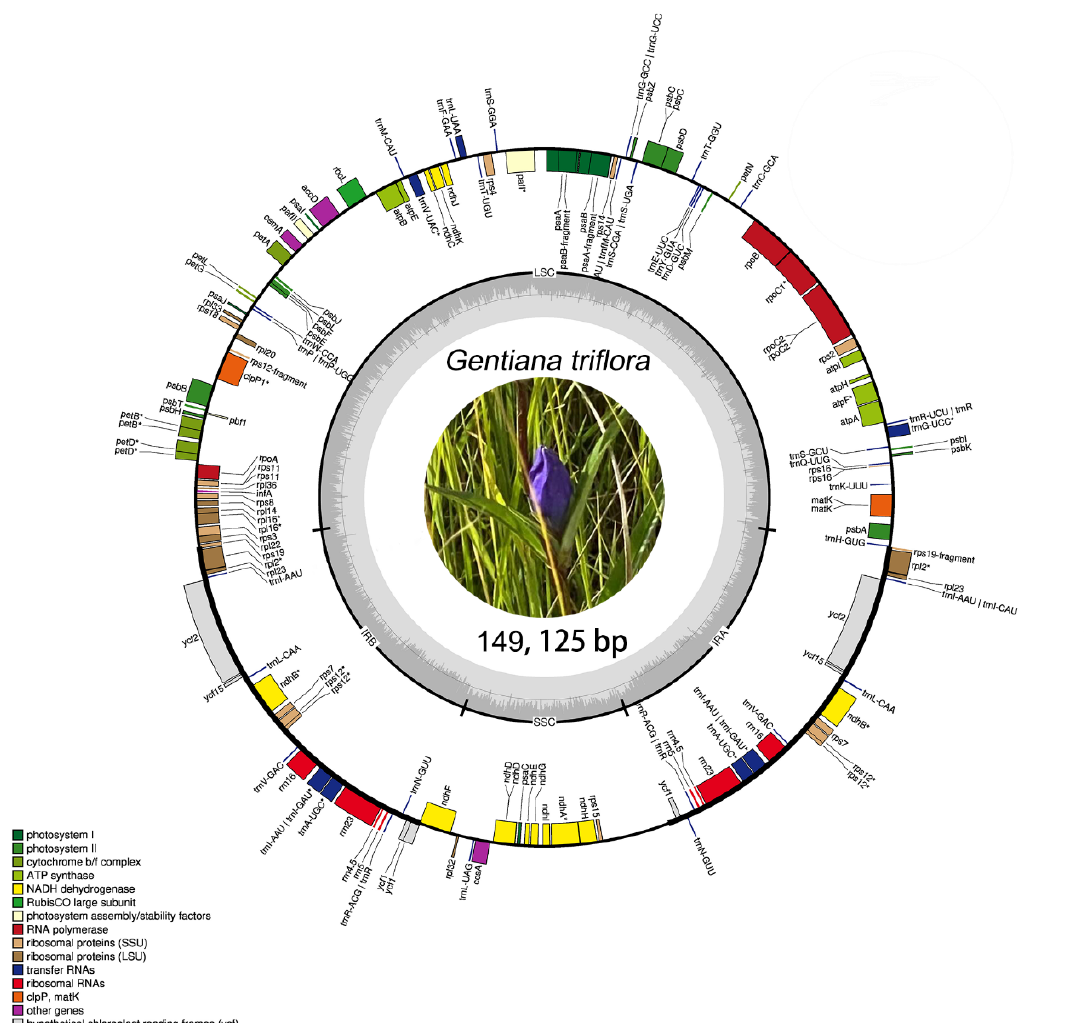
Fig. 1: Gene map of G. triflora chloroplast genome. Thick lines represent inverted repeats (IRa and IRb) which divide the genome into large and small single- copy regions (LSC and SSC). Features on the clockwise- and counter-clockwise-transcribed strands are drawn on respectively the inside and outside of the circle. The genes belonging to different functional categories were color-coded, which are shown in the left